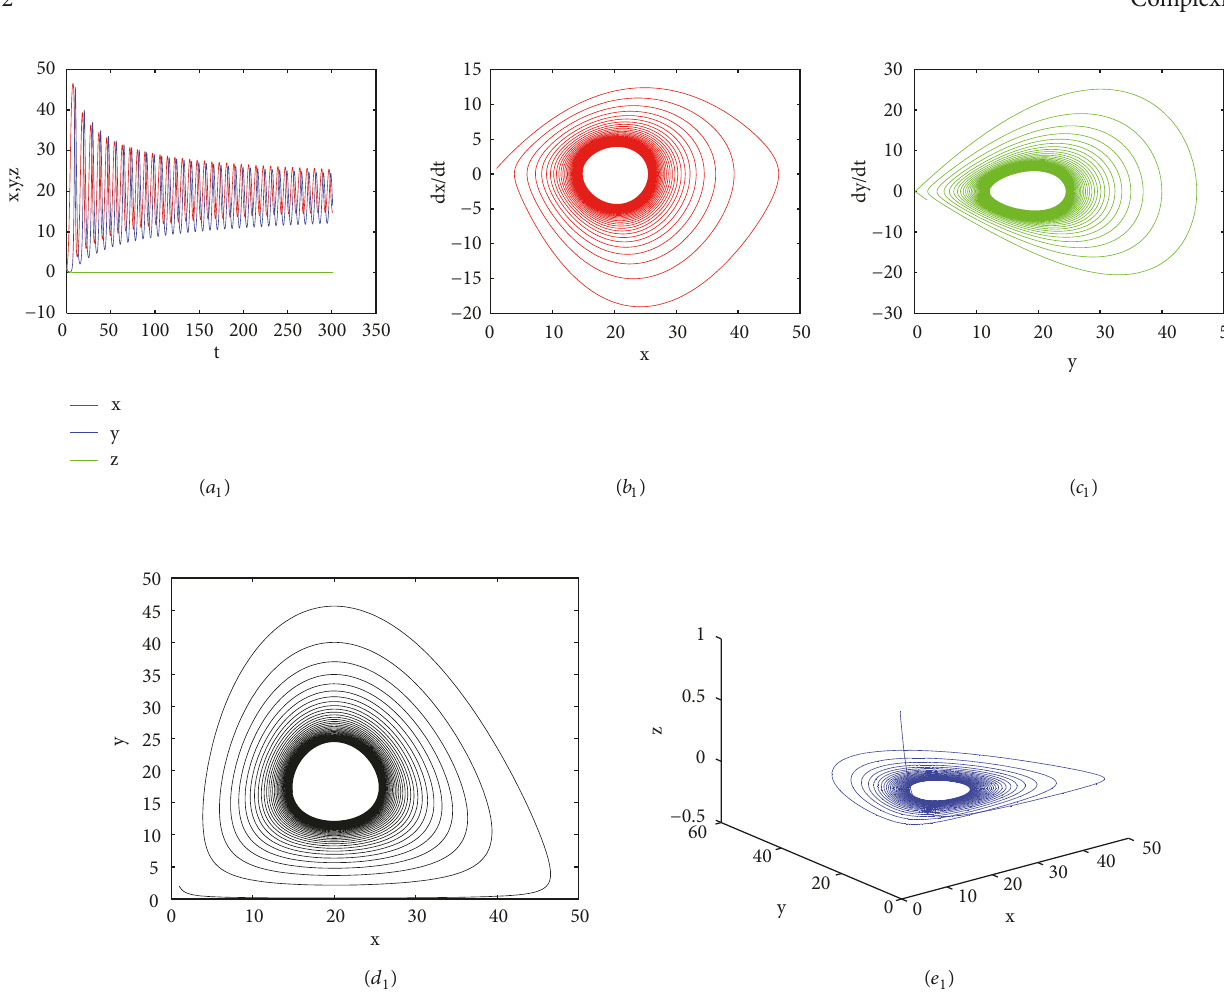
Model (2) is a totally competitive system if all parameters 𝑟 , 𝑎 𝑖 𝑖𝑗 are